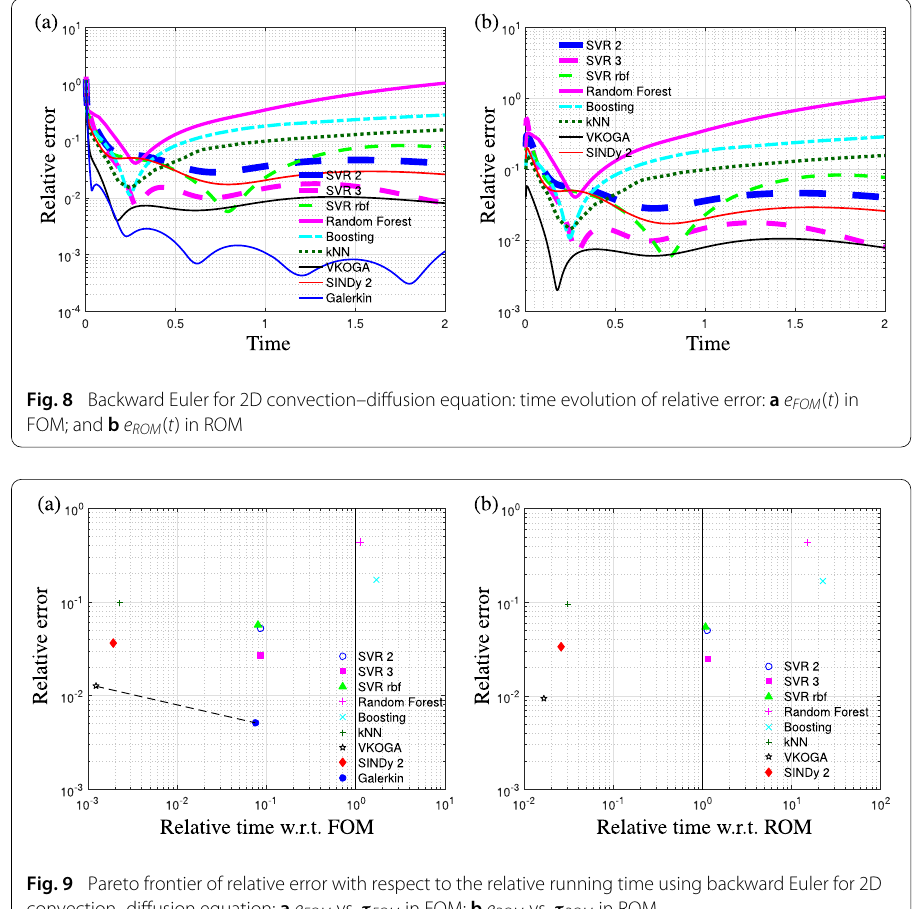
N t = 800. Figure 8 plots the state-space error with respect to FOM and ROM using the backward Euler integrator. VKOGA outperforms the other models, achieving a